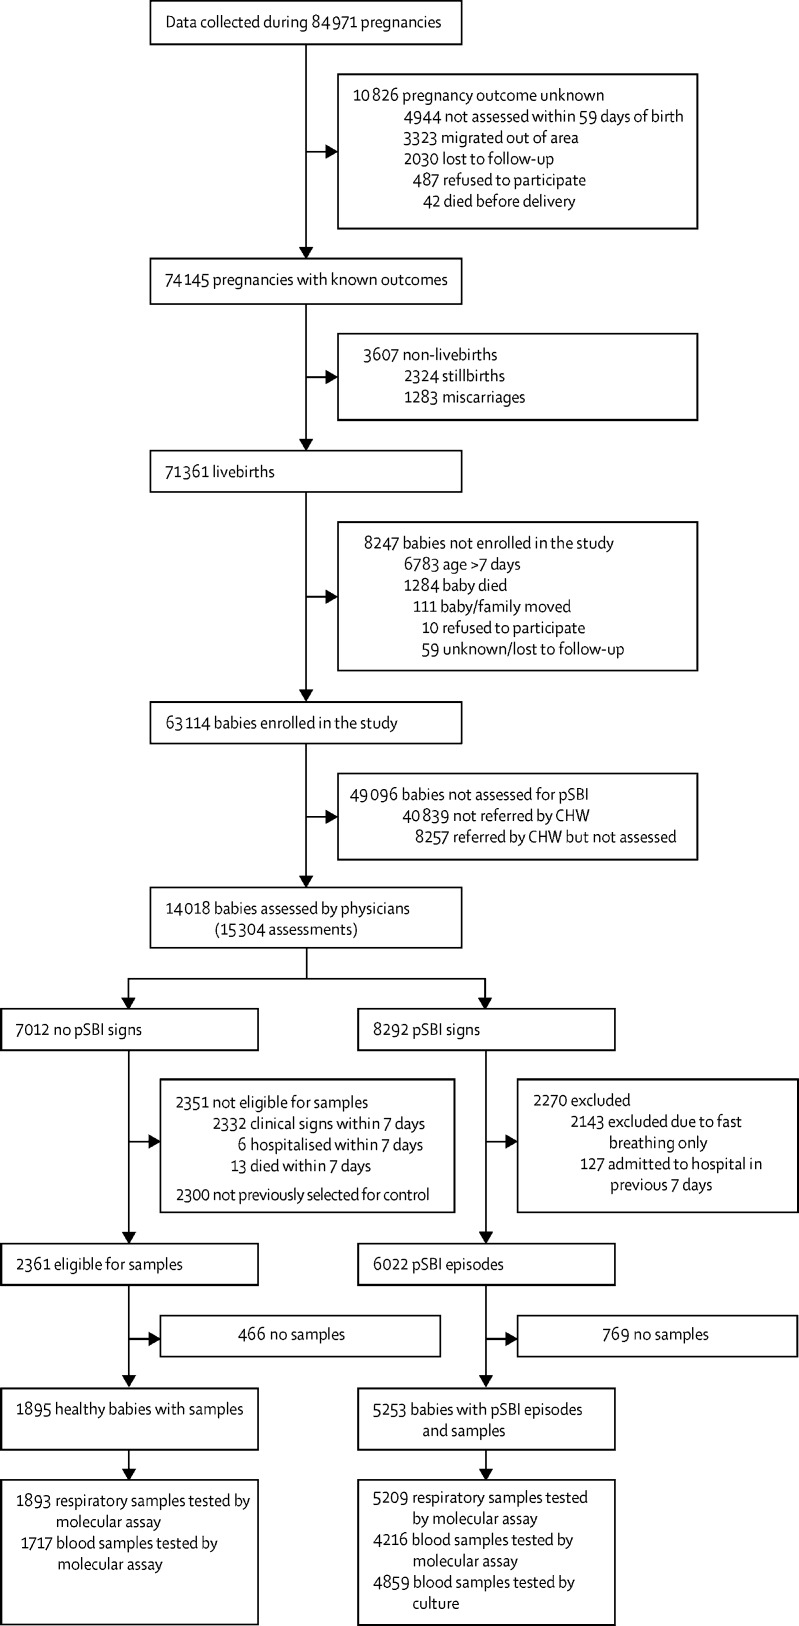
Study flow diagrampSBI=possible serious bacterial infection. CHW=community health worker.